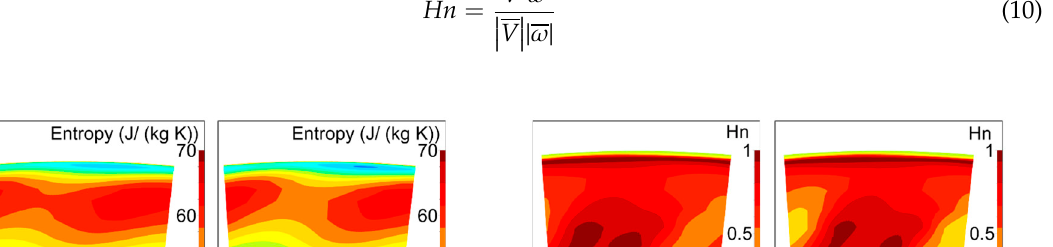
Figure 14. ( a , b ) Contours of isentropic Mach number at the rotor hub.